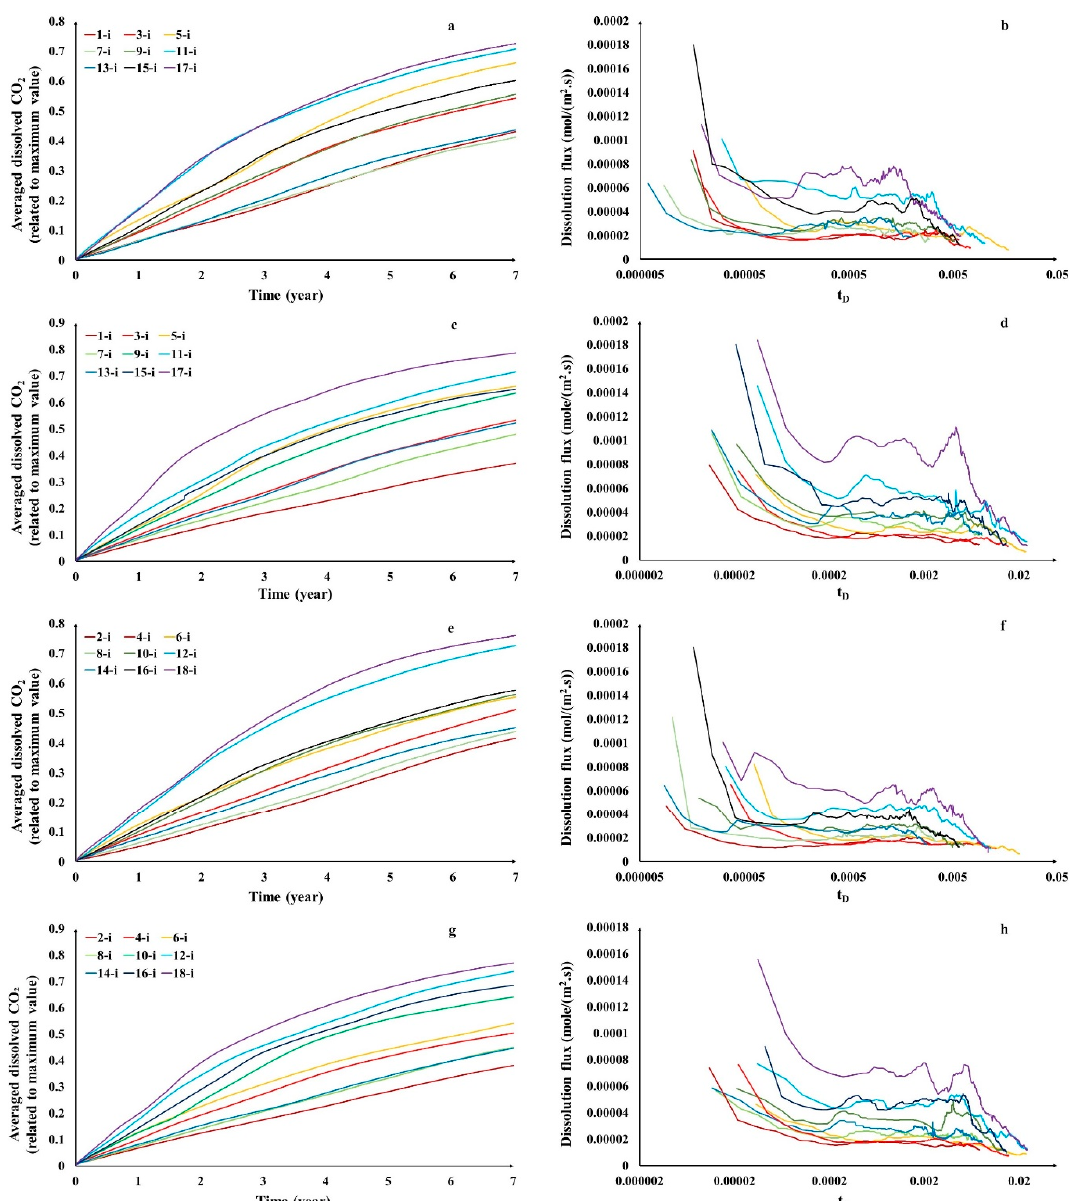
Figure 3. The averaged dissolved CO 2 and dissolution flux for the systems of 90% CO 2 -10% N 2 with considering cross-diffusion ( a , b ) and without considering cross-diffusion ( c , d ); the systems of 80% CO 2 -20% N 2 with considering cross-diffusion ( e , f ) and without considering cross-diffusion ( g , h ). Legends for left- and right-hand subplots are same.